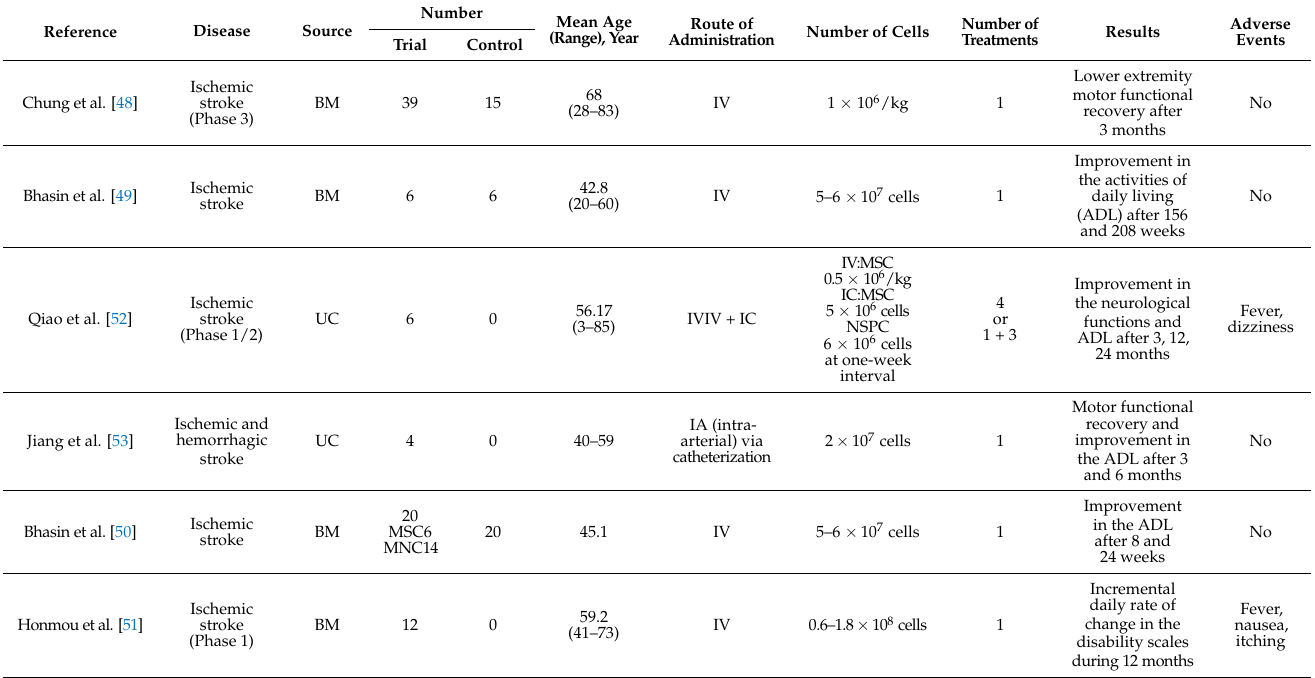
Table 1. Summary of recent clinical trials using MSCs for ischemic